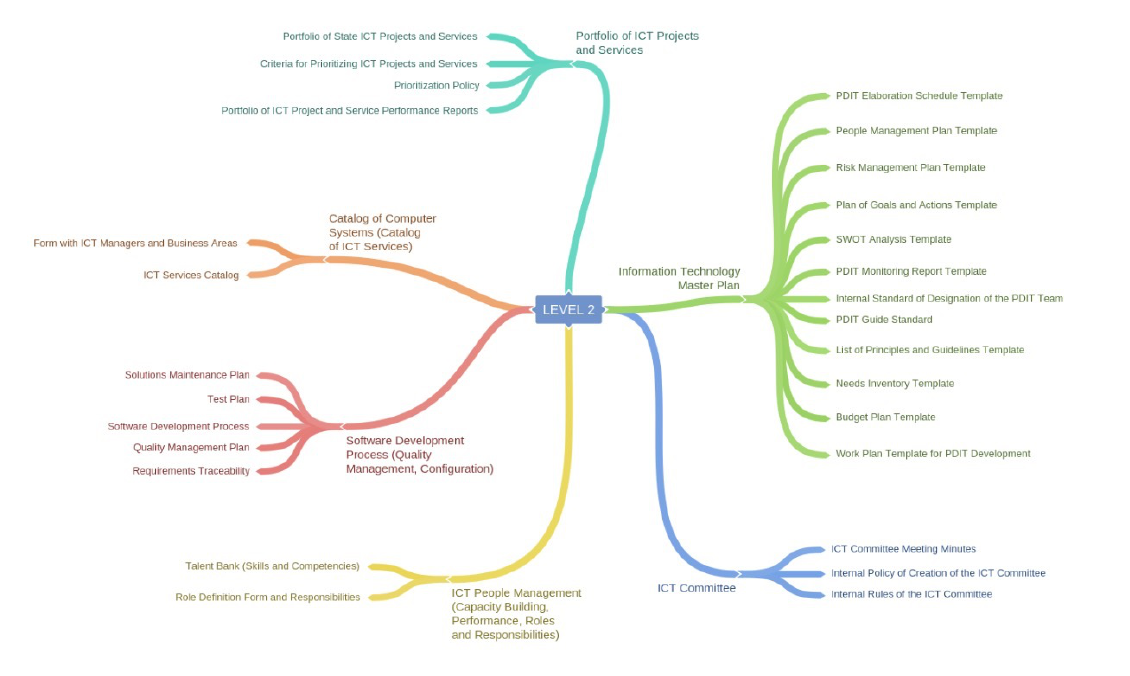
Figure 3. Processes of Kit 1.